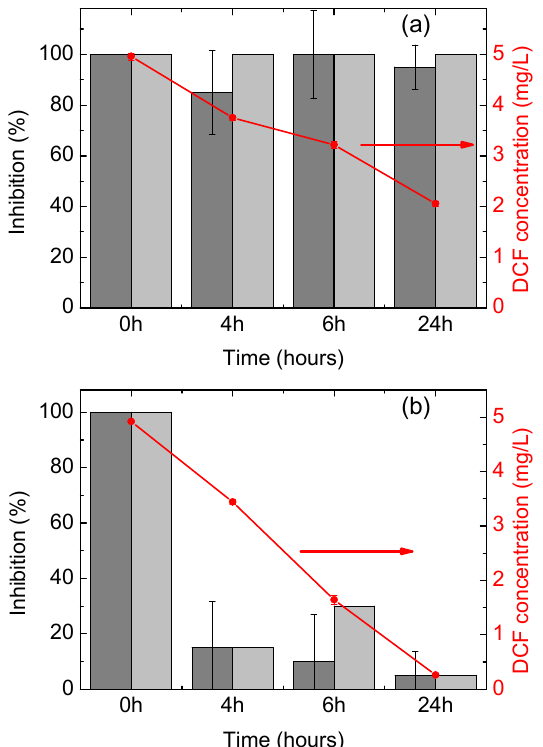
Figure 5. Acute toxicity on Daphnia magna during photodegradation of DCF using ( a ) UV light and ( b ) UV light + HApTi. Bars in dark grey refer to 24-h immobilization, while those in pale grey to 48-h immobilization (values to be read on the left axis). Error bars refer to standard deviation of quadruplicate measurements of combined duplicate samples. DCF concentration is reported on the right axis and error bars refer to standard deviation of duplicate samples.